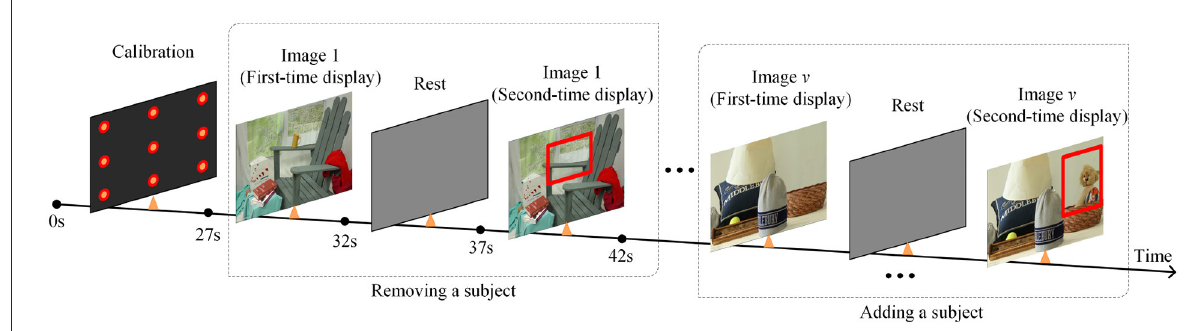
FIGURE2 The whole process description of the designed 3D VPC task.